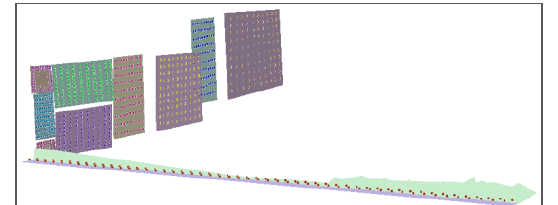
Figure 9. Billboard-road-obstruction environment with observer and target points